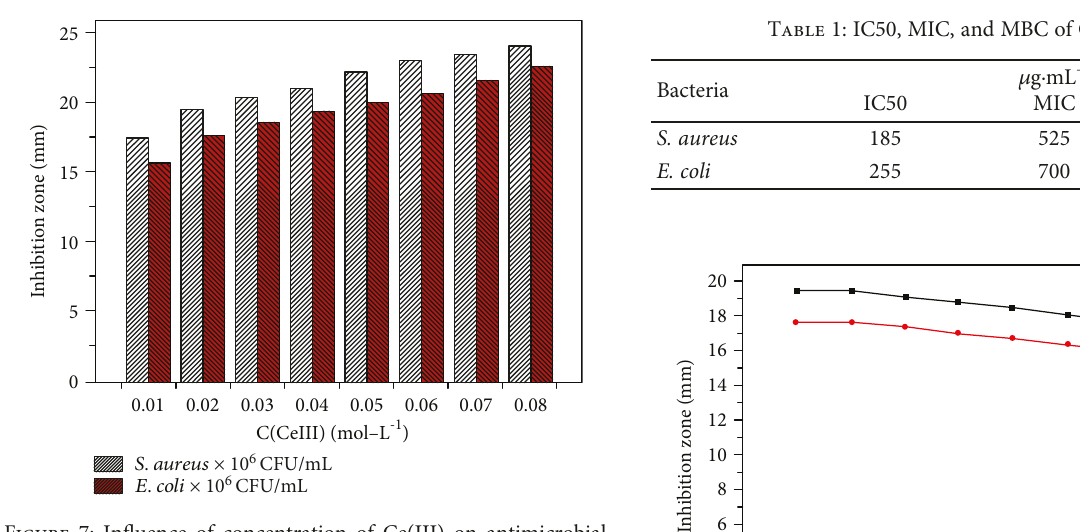
Figure 7: In fl uence of concentration of Ce(III) on antimicrobial activity.